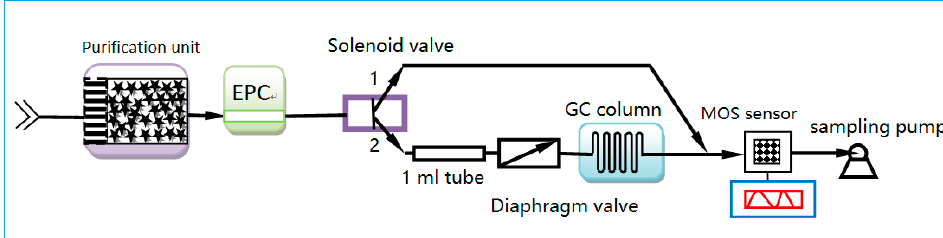
Figure 1. Configuration of the mini monitoring system.